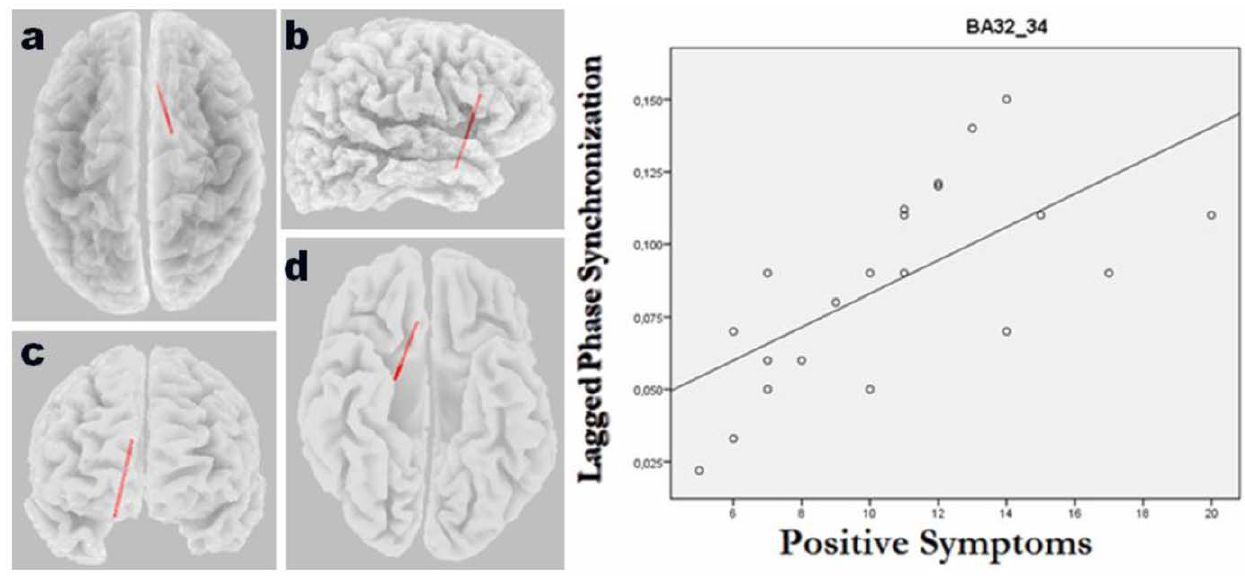
Figure 4. eLORETA wire diagram and scatterplots of significant correlations between functional connectivity ( lagged phase synchronization values) in beta2 (21–30 Hz) frequency band and psychopathology scores (i.e., positive symptoms) in patients with schizophrenia-like psychosis of epilepsy at specific regions (r=0.79; p , 0.05, corrected). The significant connectivity wire is projected onto a transparent fiducial cortical surface. a) axial view from the top; b) sagittal view from the right; c) coronal view from the front d) axial view from the base. The points to which the lines are connected represent the center of mass of the BAs. BA32_34, connectivity between Brodmann areas 32 and 34.